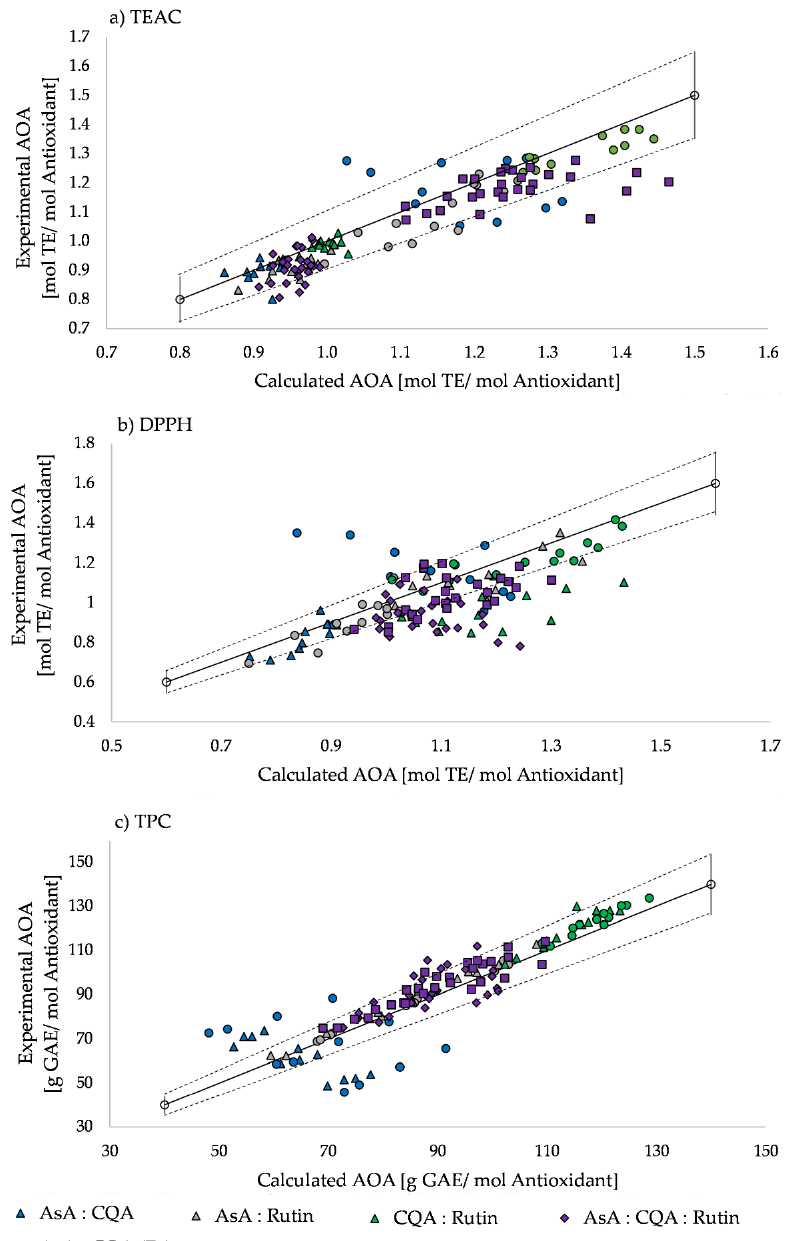
Figure 4. Synergistic and antagonistic effects based on calculated and experimental antioxidant activity (AOA) using ( a ) TEAC, ( b ) DPPH, and ( c ) TPC assays. Dots below the solid line indicate antagonistic, and above the solid line synergistic, effects. Colors indicate different mixtures, while samples with iron are marked with a dot, and those without iron are marked with a triangle. Dashed lines indicate weak antagonism ( − 10%)/synergism (+10%) with less than 10% interaction between the experimental and calculated AOA.